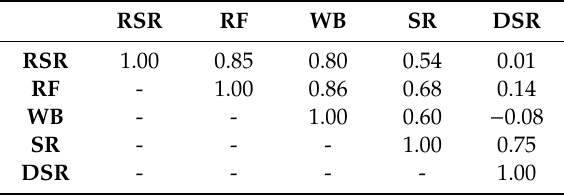
Table 2. The correlation matrix of runo ff